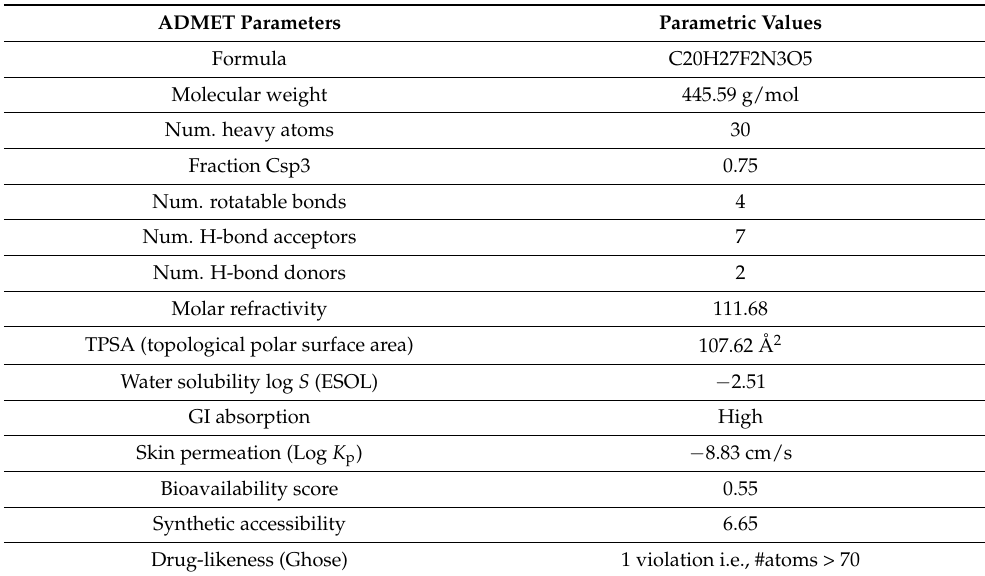
Table 3. ADMET profiling including physiochemical properties of chain-engineered dolutegravir active